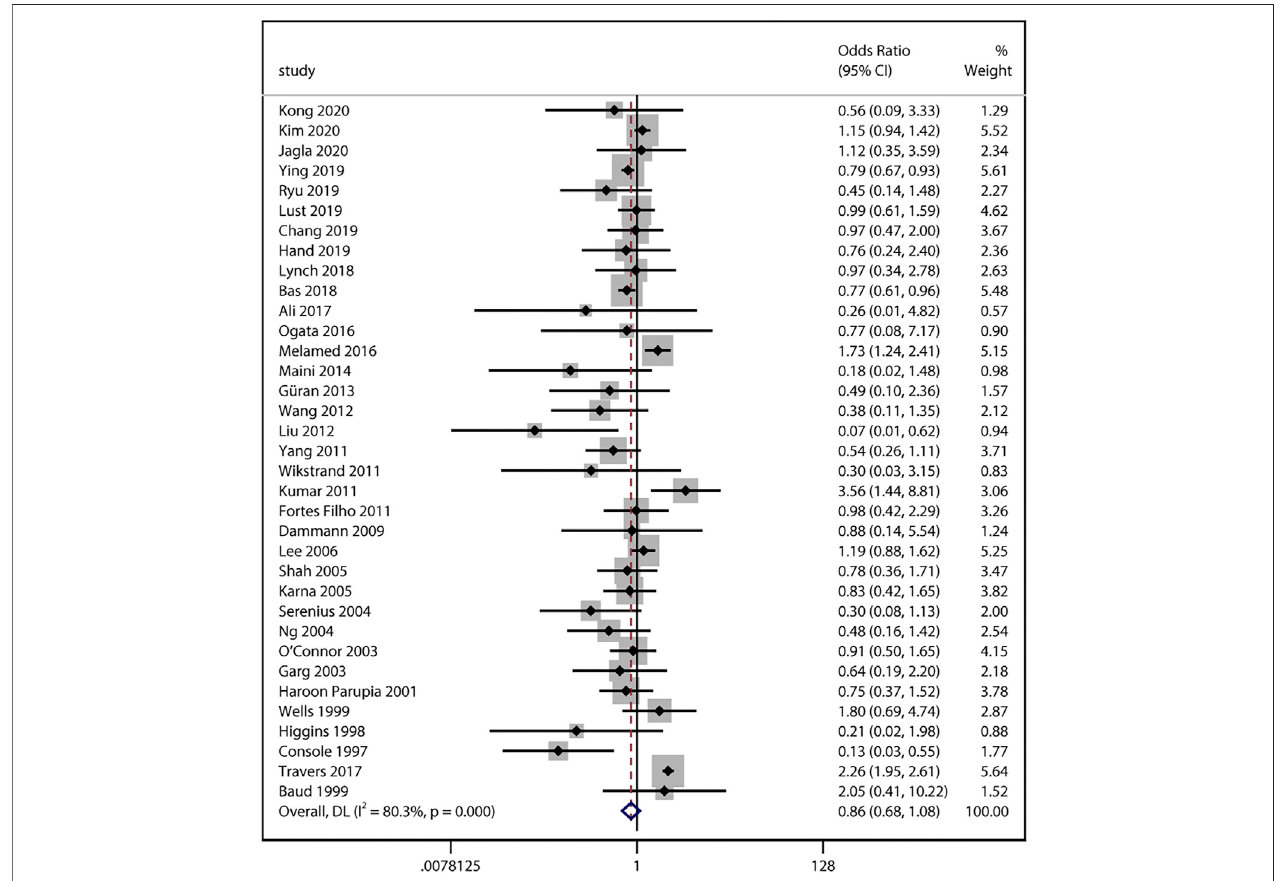
FIGURE 4 | Meta-analysis of unadjusted ORs and 95% CIs for the association between antenatal corticosteroids exposure and severe retinopathy of prematurity.